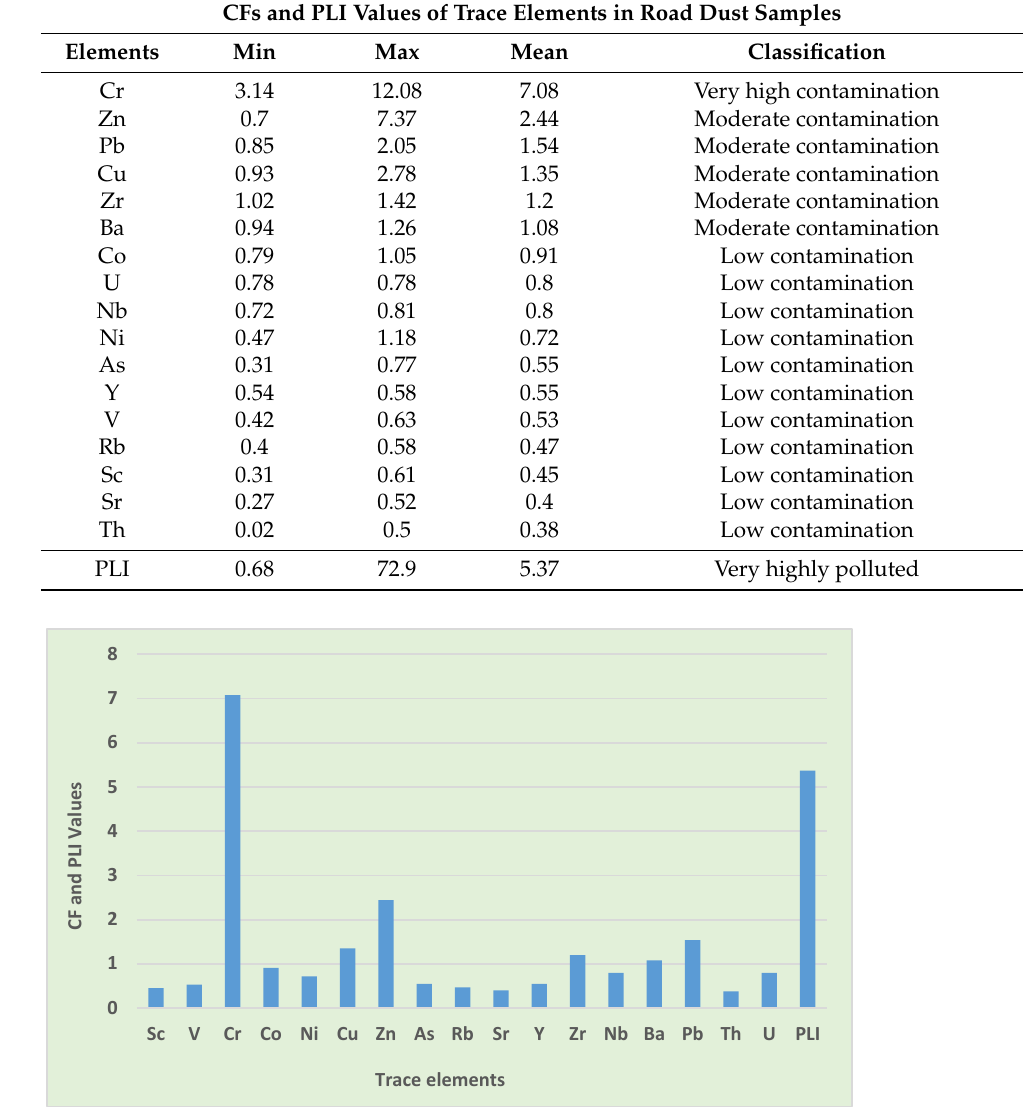
Table 7. Contamination factor (CF) and pollution load index (PLI) values of trace elements in road dust.